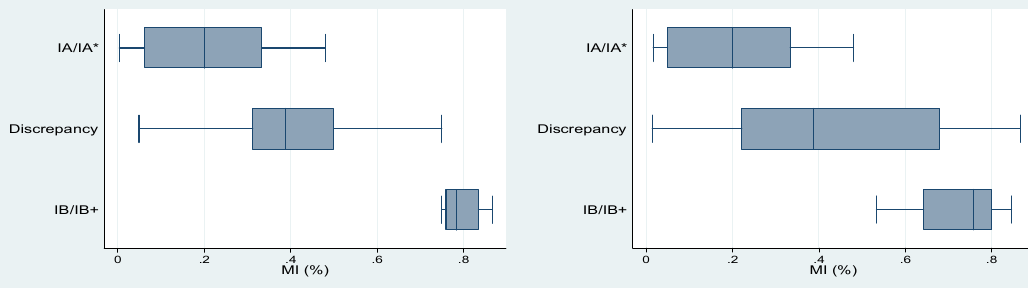
Figure 5. Box and Whisker Plot of data from AI interpretation and pathological stages (contrast- enhanced T1w and T2w). 4. Discussion